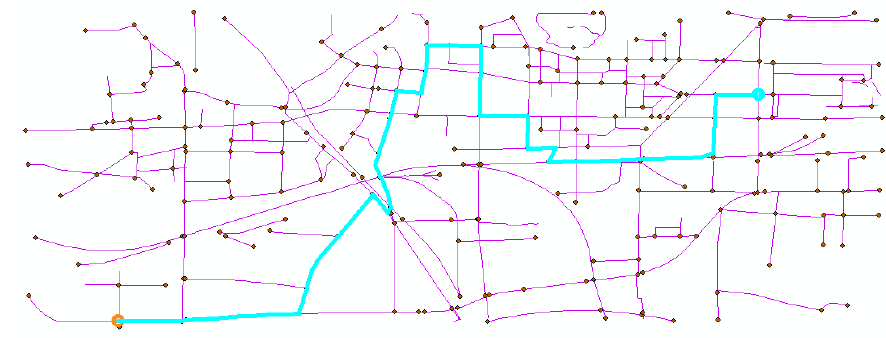
Figure 10. The best route solved by ArcGIS.